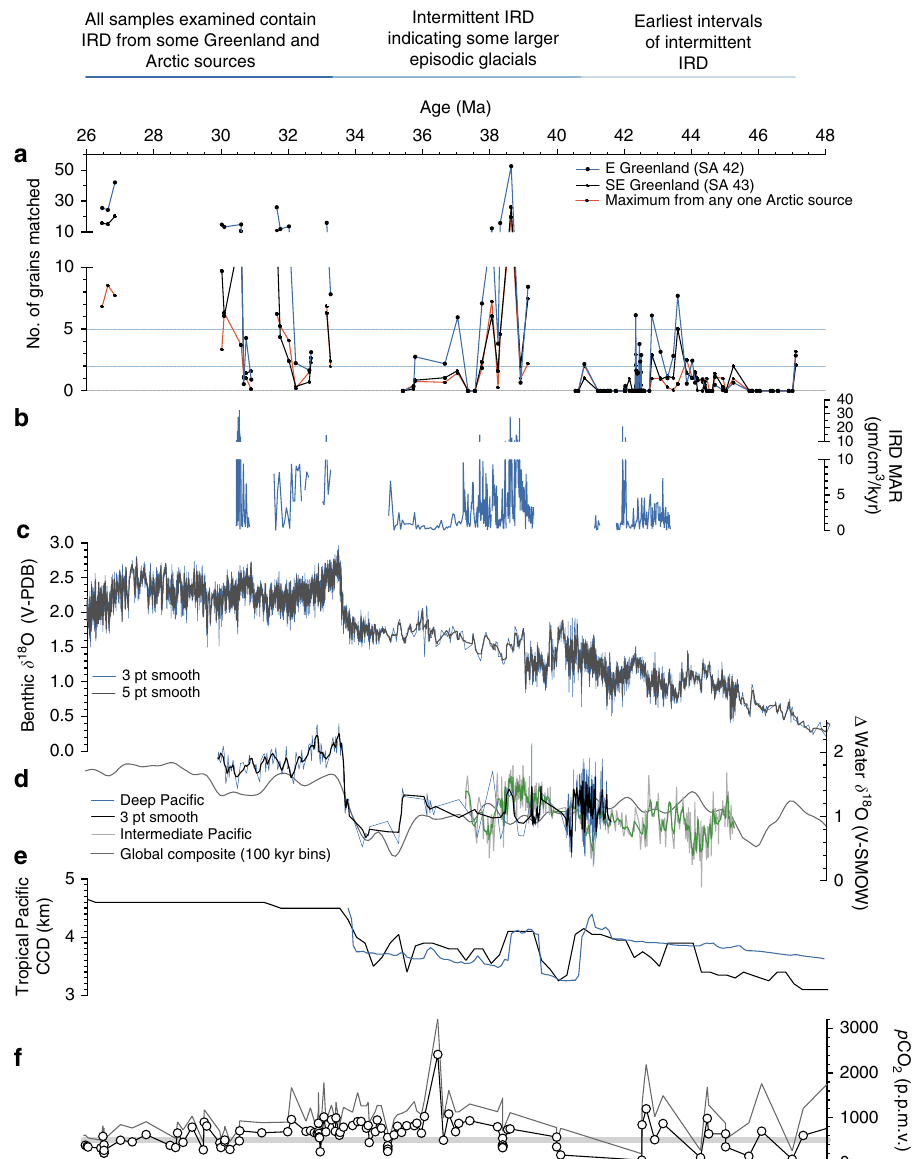
Fig. 4 Number of Fe oxide grains from Greenland and Arctic Ocean sources at Site 913 from 48 to 26 Ma compared to proxy indicators of global climate, ice volume, and carbon cycle changes. Supplementary Figures 1 – 5 show the same fi gure but with vertical blue lines to mark intervals where Greenland- sourced IRD at Site 913 occurs or when there is an increase in δ 18 O, and/or detailed insets of the fi gure. Comparison shows the occurrence of Greenland ice and circum-Arctic sea ice at Site 913 sometimes, though not always, coincides with increasing benthic foraminiferal δ 18 O and Paci fi c water δ 18 O, increases in the carbonate compensation depth, and relatively low p CO 2 . a Ice-rafted Fe oxide grains from different source regions. Horizontal blue lines indicate 2 and 5 grains matched. b IRD mass accumulation rates (MAR) at Site 913 shown, with intervals containing dropstones or grains >250 um in size indicated by underlying dotted blue line. c Composite deep-sea benthic foraminiferal δ 18 O record is shown with a 3-point and 5-point running mean. d Changes in water isotopes at sites in the intermediate and deep Paci fi c are shown, with 3-point running mean for each, is plotted with a low-resolution global composite of reconstructed water δ 18 O. Underlying blue dotted lines indicate intervals where reconstructions show an increase in water δ 18 O of more than 0.6 per mil. e Carbonate compensation depth (CCD) for equatorial Paci fi c and tropical Paci fi c are shown, which are impacted by changes in sea level and carbon cycling. Dotted lines indicating where CCD is relatively deep or increases in depth. f Composite proxy p CO 2 reconstruction is shown with lines indicating minimum and maximum values, and gray dotted line marking 500 p.p.m.v. Complete list of data sources in Supplementary